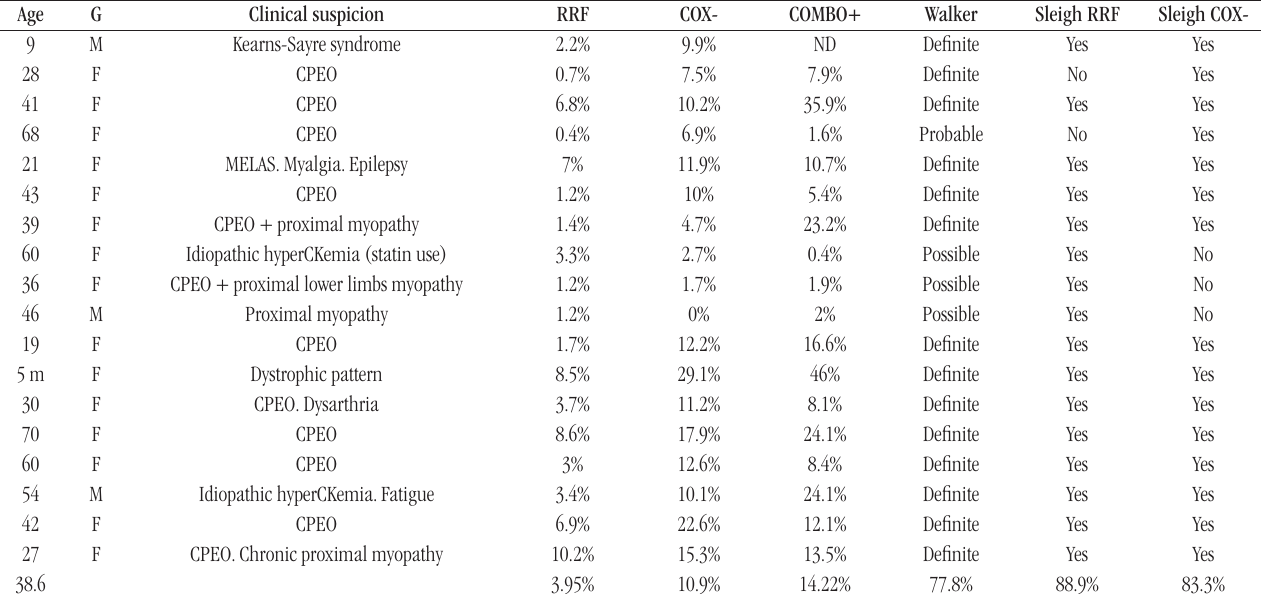
taBLE 1 − Age, gender, clinical summary, RRF, COX- and COMBO+ fibers in 18 cases with mitochondrial abnormalities. Walker clinical-pathological criteria (13) and Sleigh pathological criteria (14) are shown